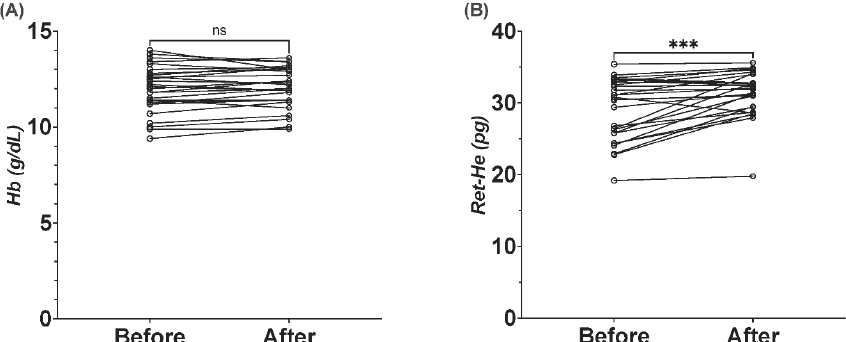
Figure 5. Time-course variation in hemoglobin, and reticulocyte hemoglobin equivalent in participants receiving iron treatment (190 mg ferrous sulphate) for one week. The graph on the left shows that hemoglobin did not change after one week of iron treatment ( A ), whereas Ret-He ( B ) had significantly increased following the treatment. Wilcoxon matched-pairs signed rank test was used to calculate the p -value. *** A p -value of <0.05 was considered statistically significant, and (ns) for